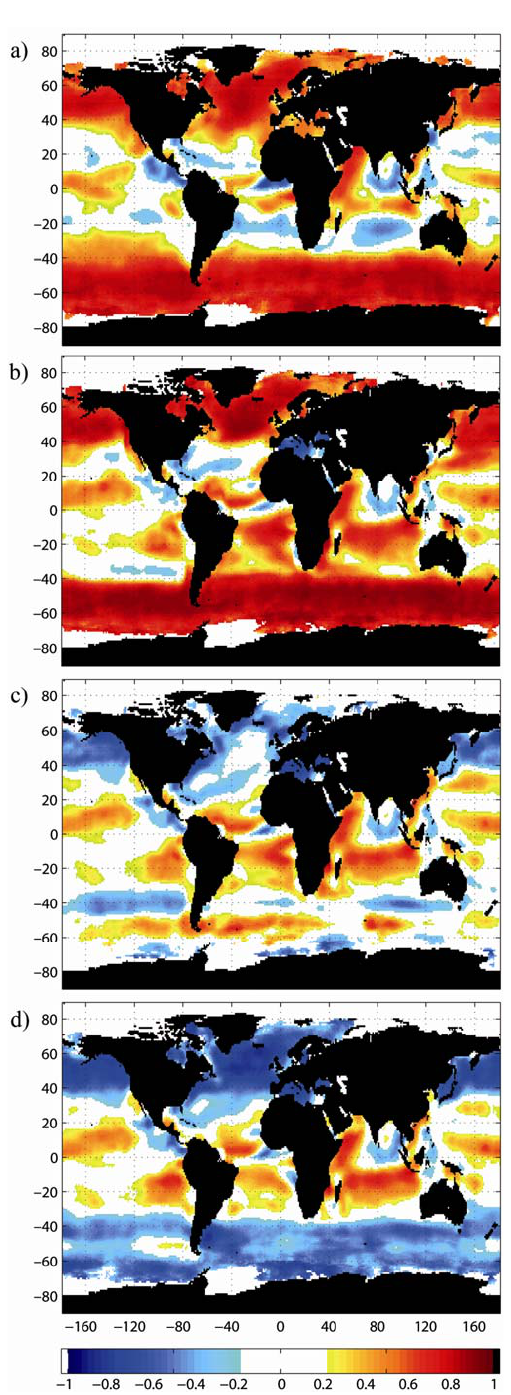
Figure 1 Fig. 1. Global maps of Spearman’s rank correlation coefficients between monthly series (2001–2009, n = 108) of MODIS-derived CCN number concentrations and the parameterized oceanic fluxes of: (a) DMS emission and oxidation in the atmosphere ( γ DMSflux), (b) SOA formation in the atmosphere (SOAflux), (c) POA emission (POAflux) and (d) sea salt emission (SSflux). White areas show non-significant